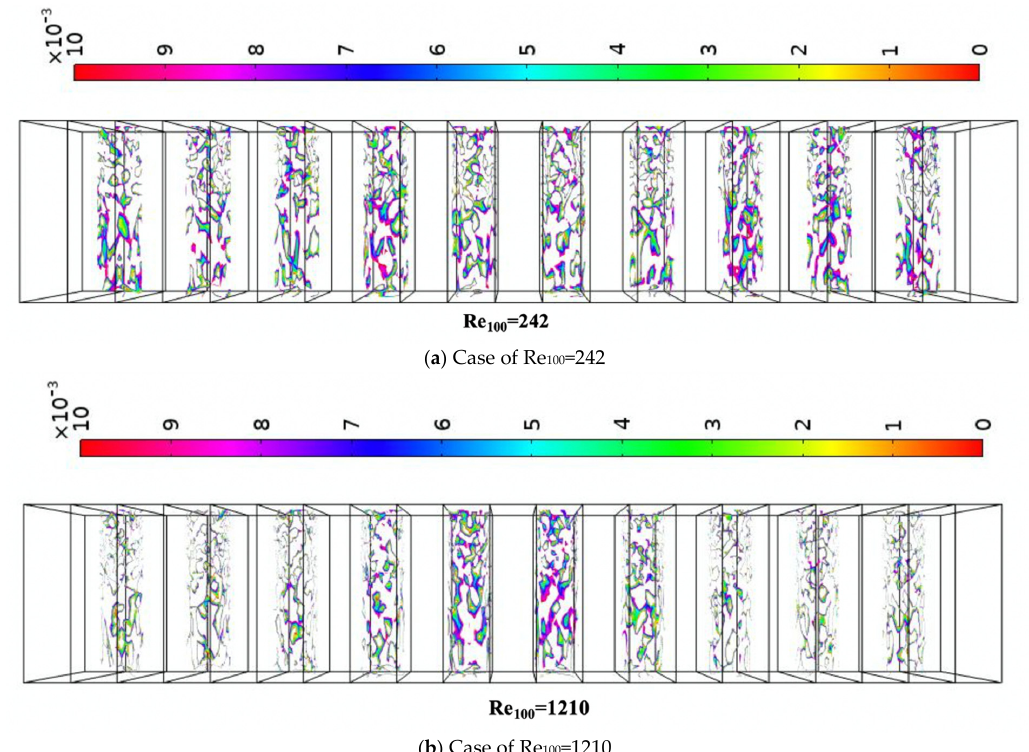
Figure 11. Nanoparticles are distributed at the middle of the insert (AR = 6, dp = 100 nm). In Figure 10, the concentration is displayed randomly for the case of Re 31 = 239 and Re 31 = 1200. For those cases, the size of nanoparticles is 31 nm. Figure 11 presents a similar case when the size of the nanoparticles is 100 nm, corresponding to a Reynolds number Re 100 = 242 and Re 100 = 1210. The first observation which is worth noting is that at a lower Reynolds number, as the nanoparticles’ size increases, the flow circulating above the chan- nels discourages the nanoparticles from passing through the channel, and thus there are few nanoparticles in the channel. As the Reynolds number increases, for the small nano- particles case, they pass through the channel due to the interaction between the flow above and in the channels. However, as the nanoparticles increase, fewer nanoparticles in the channels are observed. Additionally, we discover a non-uniform nanoparticle distribution between a channel for one case. This is since the fluid enters around the center of the channel, and thus there is less flow in passing by the channels near the walls of the exper- imental setup. 4.4. Heat Performance for All Cases It is important to assess the performance of different configurations and cases to be able to extrude the best scenario possible for cooling. The novelty of the current work is to investigate the importance of aspect ratio or, in other terms, the channel heights. Addi- tionally, the uniqueness of this study is the flow interaction between the portion circulat- ing inside the channel and passing on top of the channel. This flow behavior is valid only for aspect ratios AR = 3, 6, and 9, respectively. They must be of an optimum configuration that may lead to the best performance of the system.